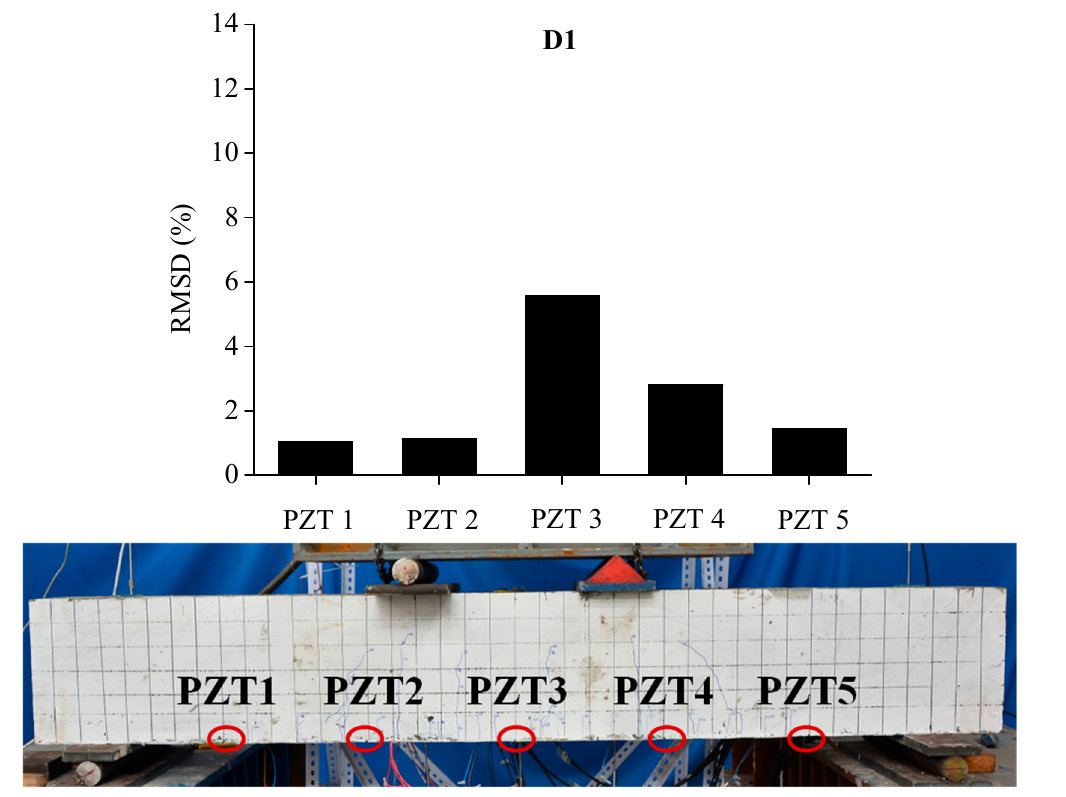
Figure 13. RMSD of each PZT sensor at D1 and the related cracking pattern of BE1.